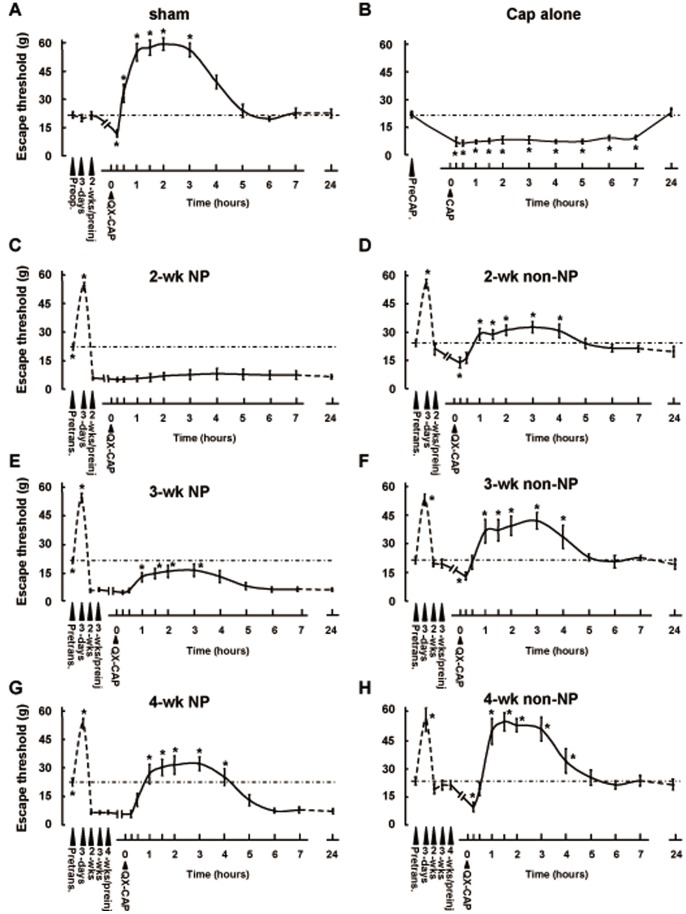
The effect of QX-CAP application on the escape threshold of NP and non-NP group at different time points after IAN transection.The changes in escape threshold following subcutaneous application of QX-CAP in sham-operated group (A); Only CAP injected sham-operated group (B); 2-weeks NP group (C); 2-weeks non-NP group (D); 3-weeks NP group (E); 3-weeks non-NP groups (F); 4-weeks NP group (G); 4-weeks non-NP group (H). The measurement were performed before the transection, 3 days after transection, 2, 3, and 4 weeks after transection/sham operation (depending on groups) and at various time points after injection of QX-CAP or CAP (n = 15 for each group, ANOVA followed by Dunnett’s test, *p<0.05). QX: QX-314; CAP: Capsaicin; Preop.: Preoperation; Preinj.: Preinjection; Pretrans.: Pretransection.